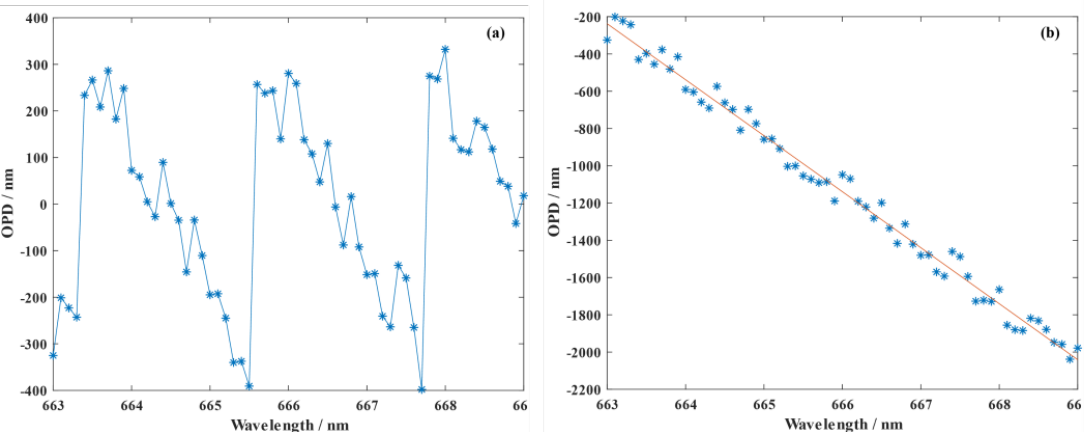
Figure 3. Wavefront measure errors ’ influence ( a ) before correction and ( b ) after correction. When wavefront measurement errors exist, Equation (1) changes as follows, where is the error term. i